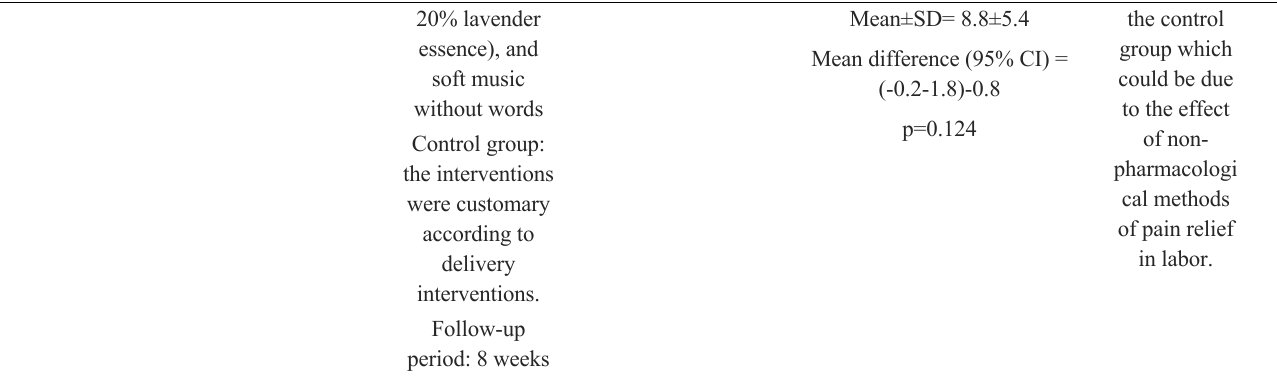
Table 1. Summary of data extracted from the reviewed articles